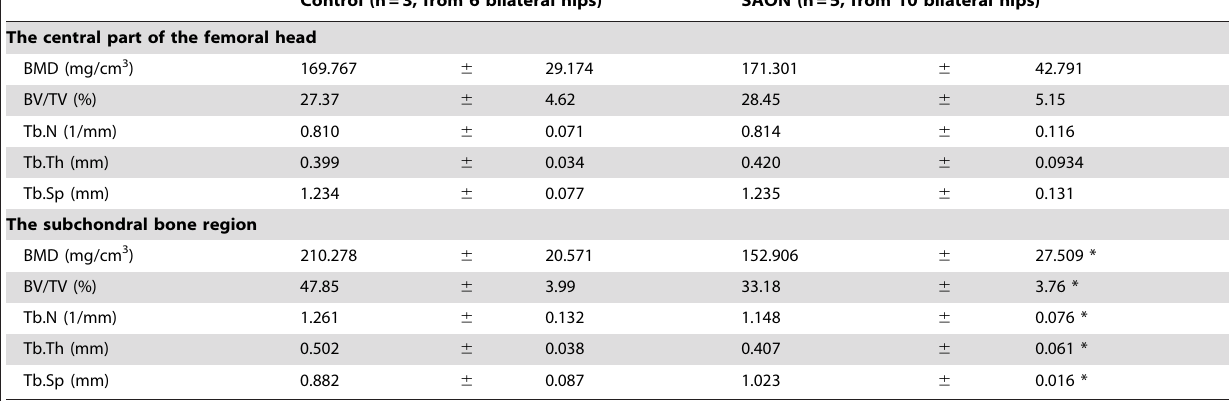
Control (n=3, from 6 bilateral hips) SAON (n=5, from 10 bilateral hips)